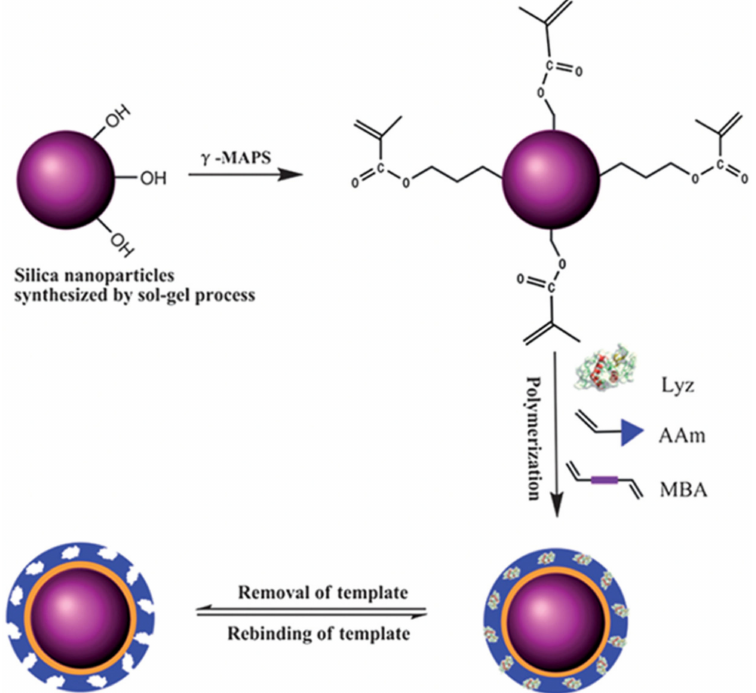
Figure 3. General scheme of surface Lyz imprinting over the surface of silica nanoparticles. Repro- duced with permission from [52].